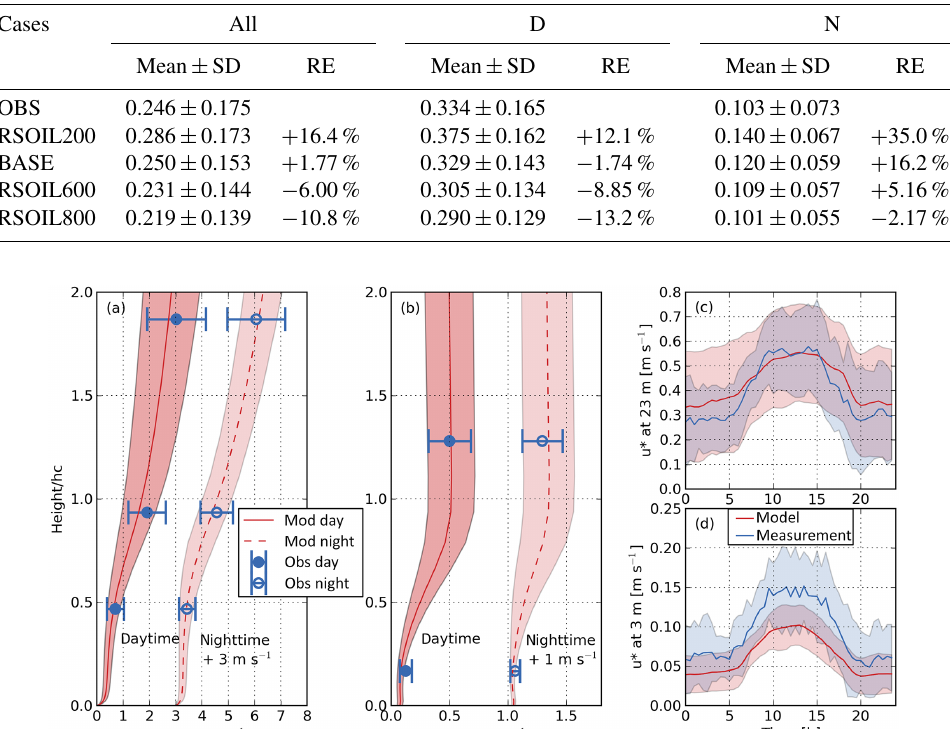
Table 2. The average (mean) and standard deviation (SD) of modelled and measured O 3 fluxes (µgm − 2 s − 1 ) above the canopy dur- ing different time periods (All for the whole month, D for daytime, N for nighttime) for different cases (OBS for measurement, BASE for basic settings used in this study, RSOIL200 uses the same settings as in BASE except r soil = 200sm − 1 , similarly, RSOIL600 with r soil = 600sm − 1 and RSOIL800 with r soil = 800sm − 1 ) are shown. The relative error (RE) of modelled O 3 flux compared to the observa- tion (F t,mod − F t,obs )/F t,obs is also presented.